Question: Is the quantity shown trending increasing or decreasing?
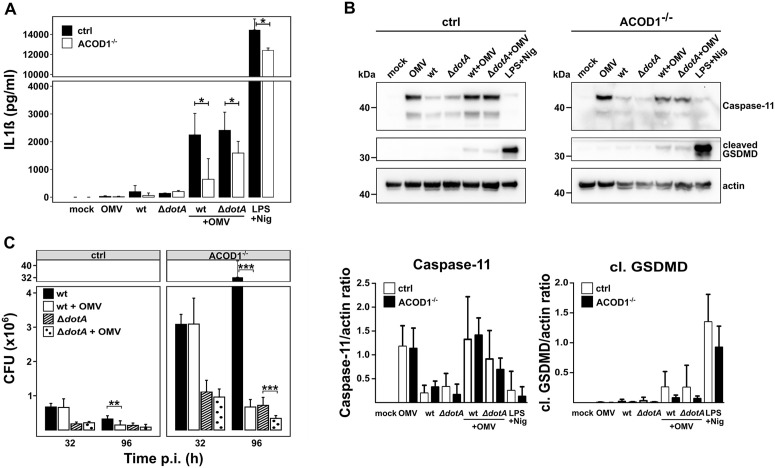
Answer: increasing